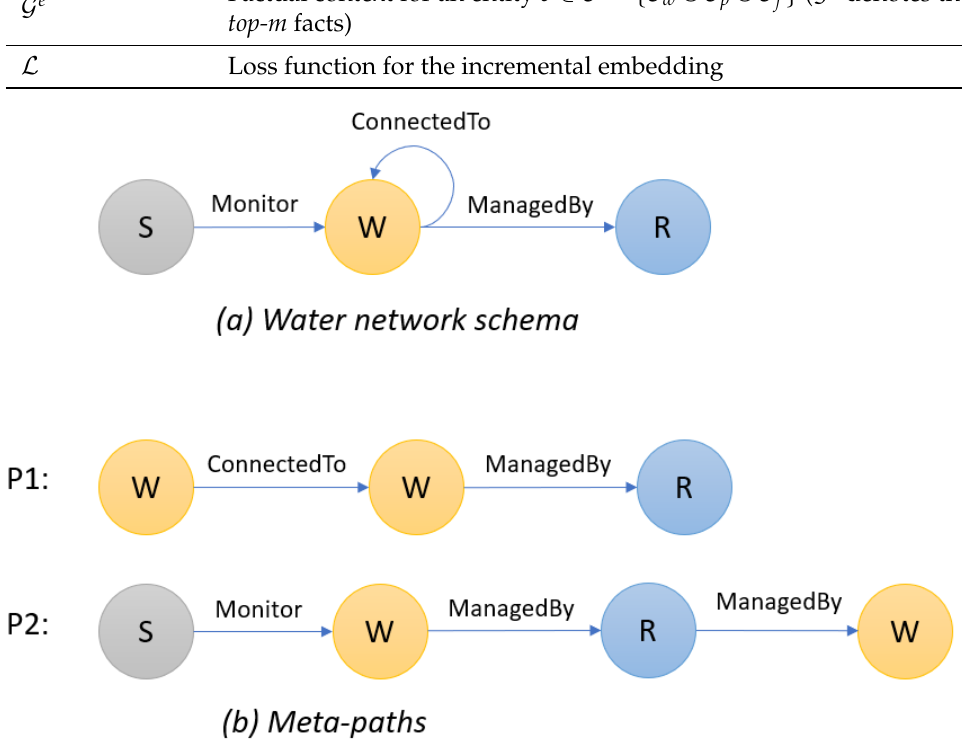
Figure 6. A simple water network schema and two possible meta-paths in the water